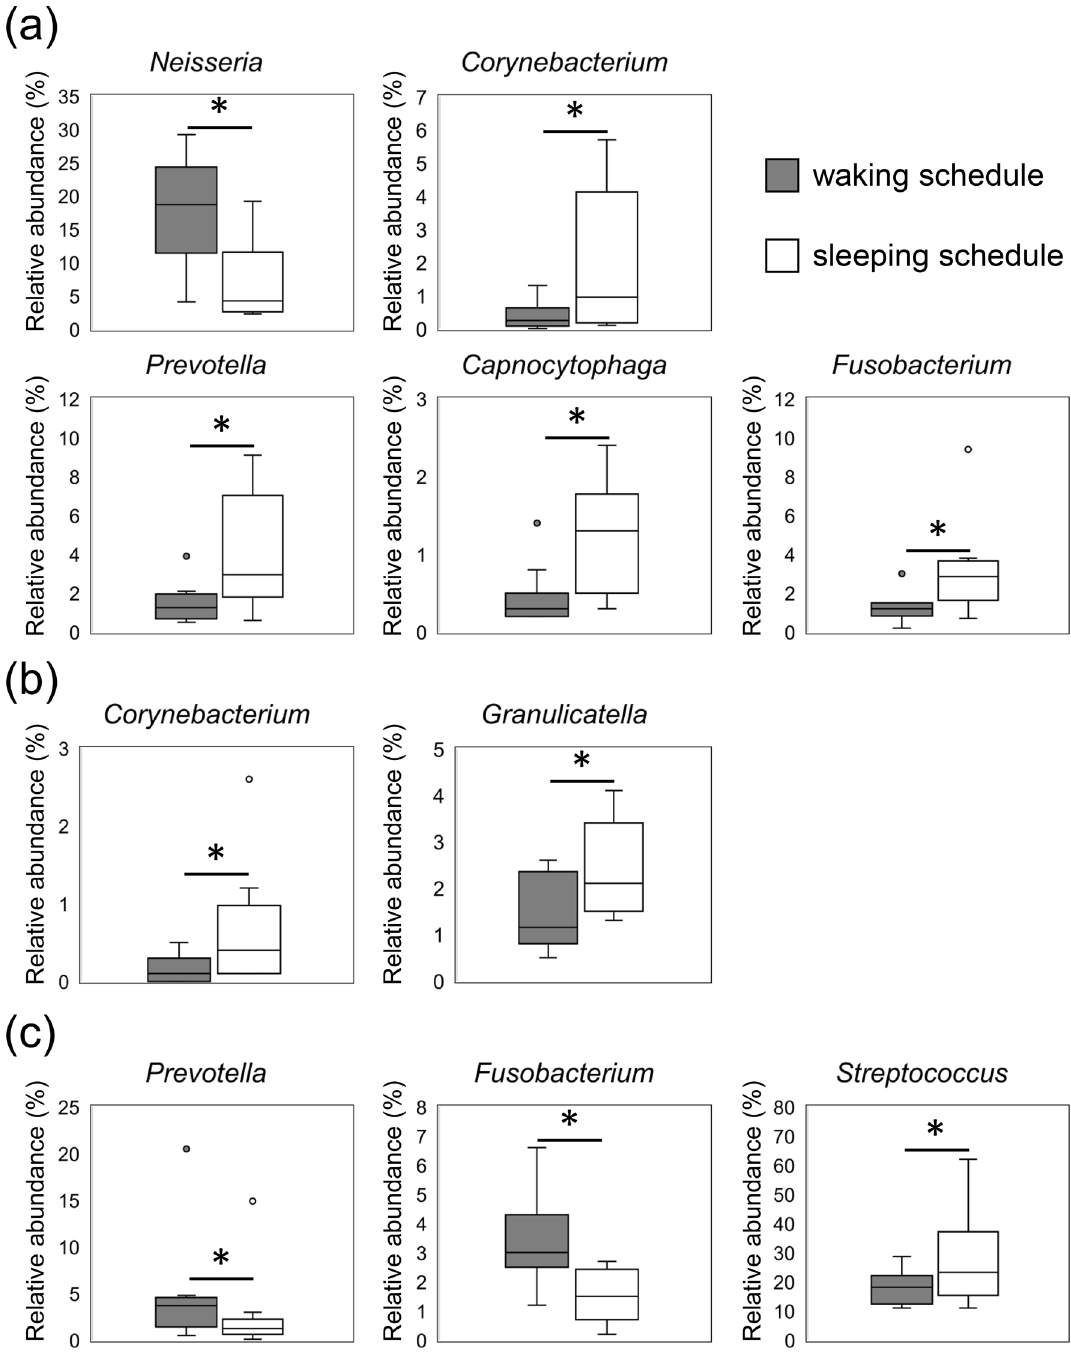
Figure 6. Genera with significantly different relative abundances between the waking and sleeping schedules. ( a – c ) Genera for which significant differences in abundance were observed between dental biofilms from the waking and sleeping schedules at 8 h ( a ), 16 h ( b ), or 24 h ( c ) (Wilcoxon signed rank test, p < 0.05). Circles represent